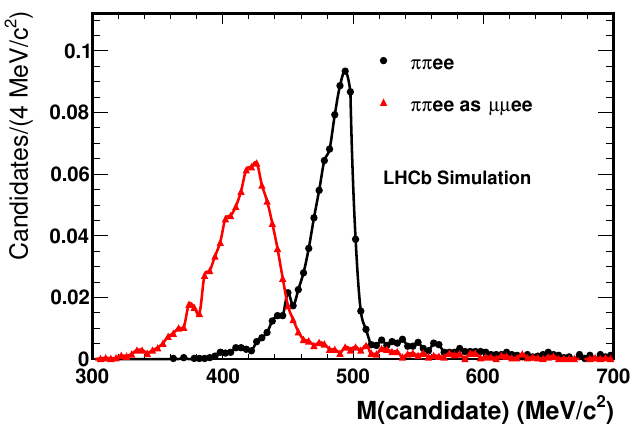
Figure 5 . Expected invariant-mass shape of K 0 (cid:22) + (cid:22) (cid:0) e + e (cid:0) mass hypothesis, taken from ref.